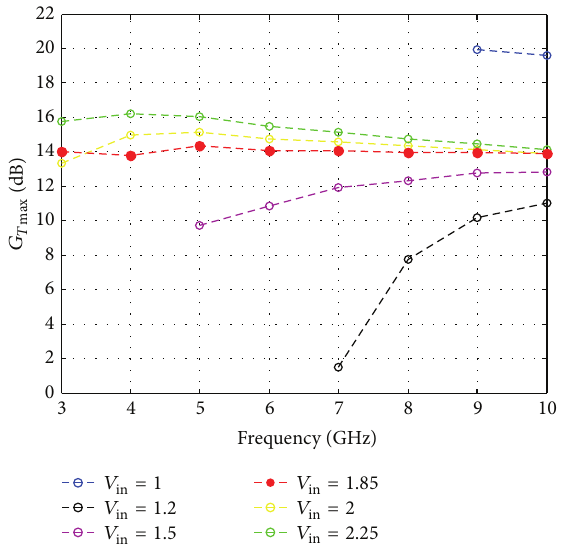
Figure 7: Maximum transducer gain for different input VSWR